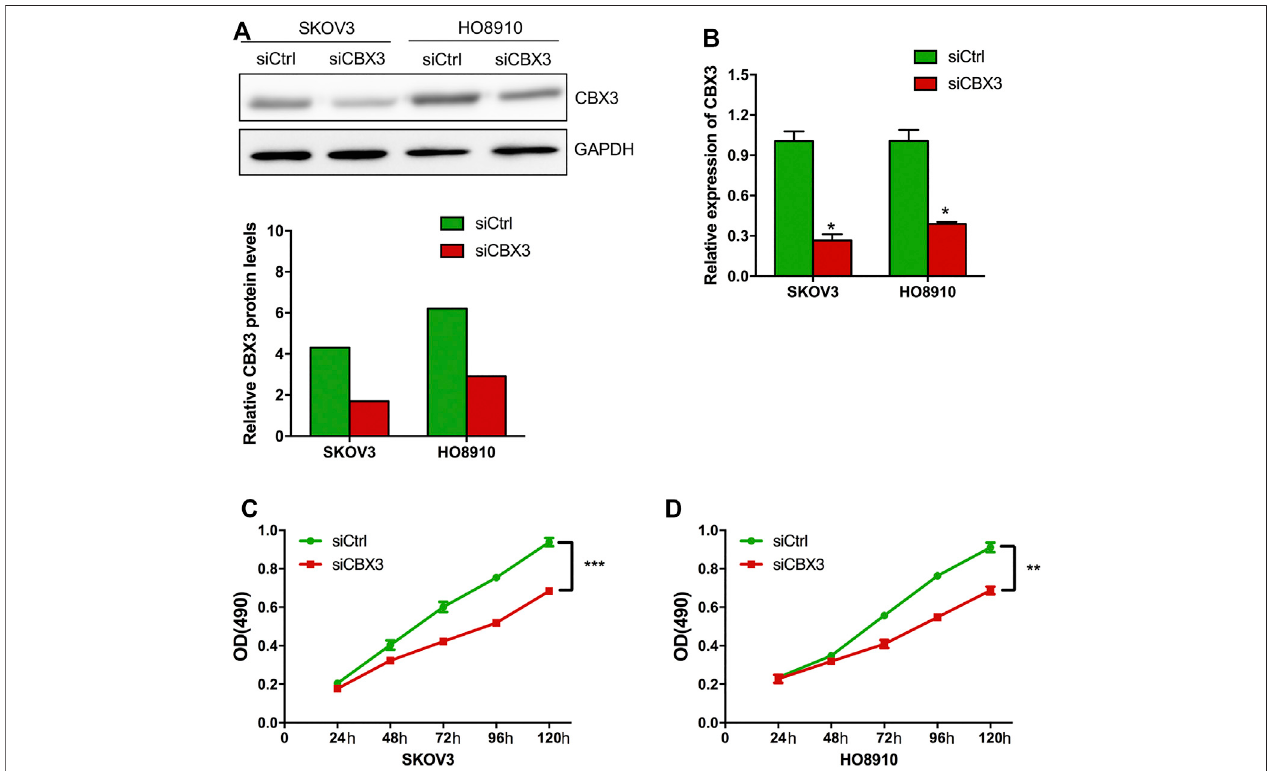
FIGURE 5 | CBX3 knockdown inhibited the proliferation of ovarian cancer cells. (A) The knockdown ef fi ciency of CBX3 in SKOV3 and HO8910 was evaluated by Western Blot. (B) The knockdown ef fi ciency of CBX3 in SKOV3 and HO8910 was assessed by qRT-PCR. (C – D) CCK-8 assay was conducted to evaluate the effect of siCBX3 on the proliferation of SKOV3 and HO8910 cell lines. ** p < 0.01, *** p < 0.001.